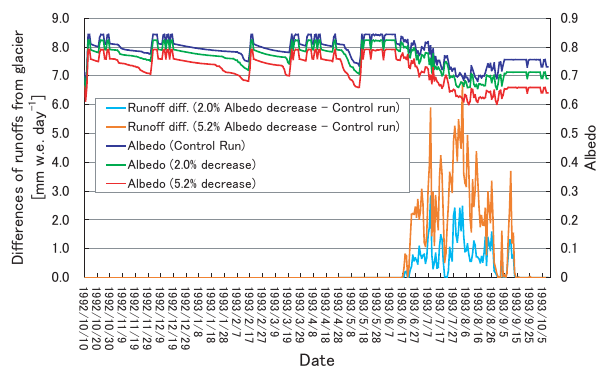
Fig. 8. Increases of snow melt runoff from Dongkemadi Glacier due to continuous albedo reductions of 2.0% and 5.2% in the nu- merical experiments. The lines in blue, green, and red denote the areal weighted mean of snow albedos along each altitude in the do- main of Fujita (2007) and Fujita et al. (2007) for the cases of control run (no forced albedo reduction), 2.0% albedo reduction, and 5.2% albedo reduction, respectively. The lines in sky blue and orange de- note the differences in snow melt runoff from the glacier between the cases of 2.0% albedo reduction and control run and between 5.2% albedo reduction and control run,